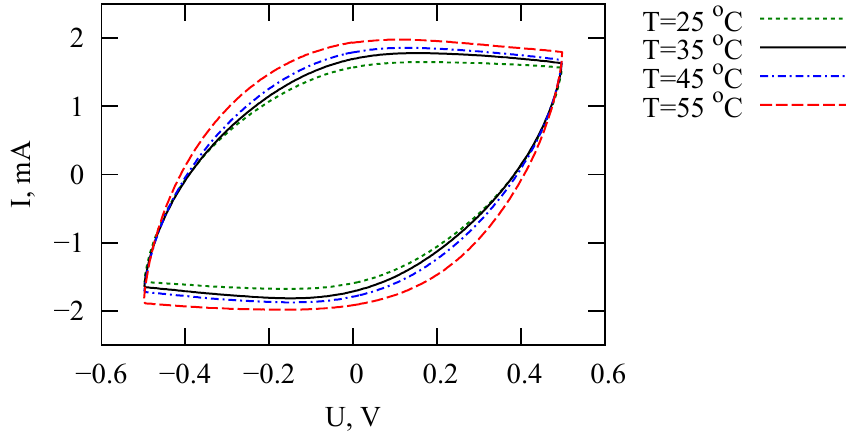
Figure 8. Cyclic voltammograms (10th cycle, scan rate is 50 mV/s) of PANI/VA-MWCNT pseudo- capacitors for different temperatures.